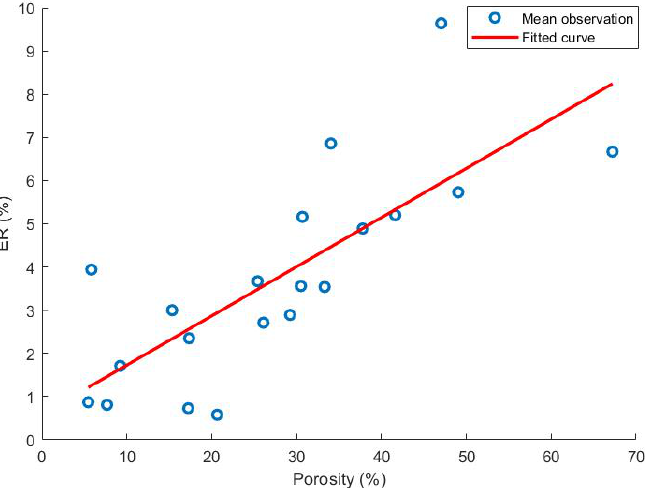
Figure 5. The correlation between the elastic recovery (%) and the porosity (%) as determined with helium pycnometry. Reported observations are the mean values of 10 (ER) or 3 (He pycnometer) repetitions for each run. First order linear fitting was performed, and an R 2 of 0.61 was